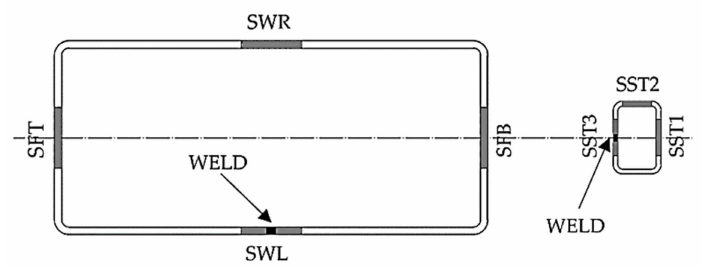
Figure 3. Positions form where coupons were taken and their belonging